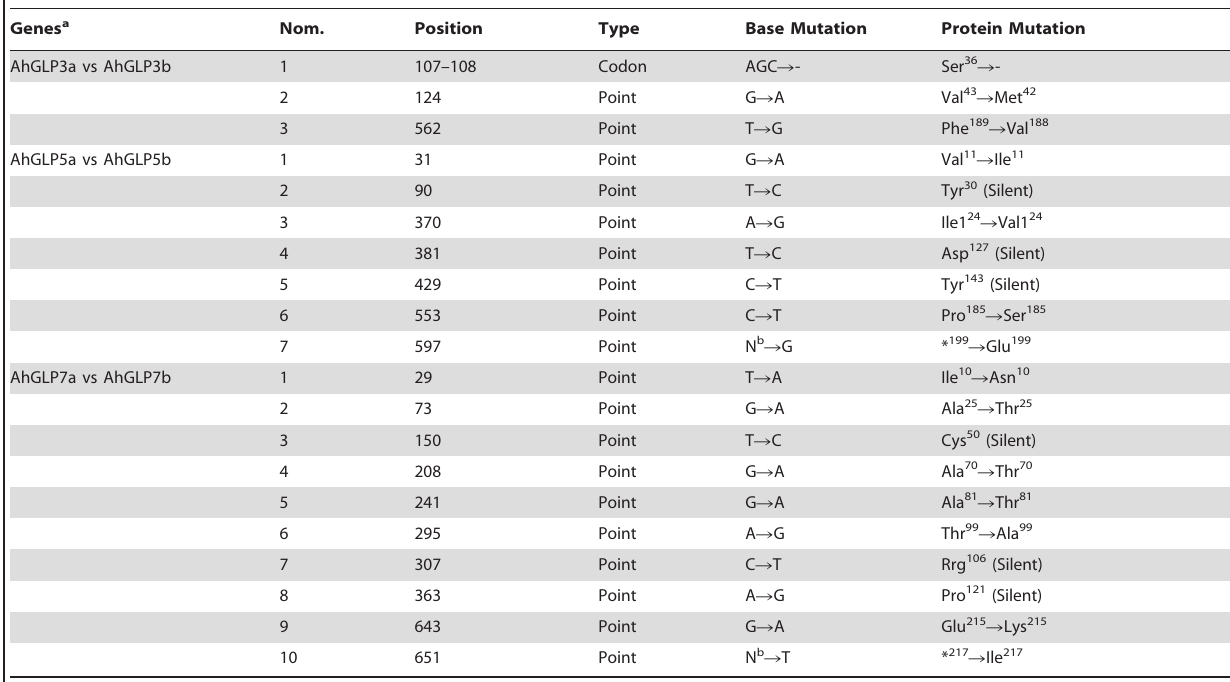
Table 1. Difference of closely related multiple AhGLPs .